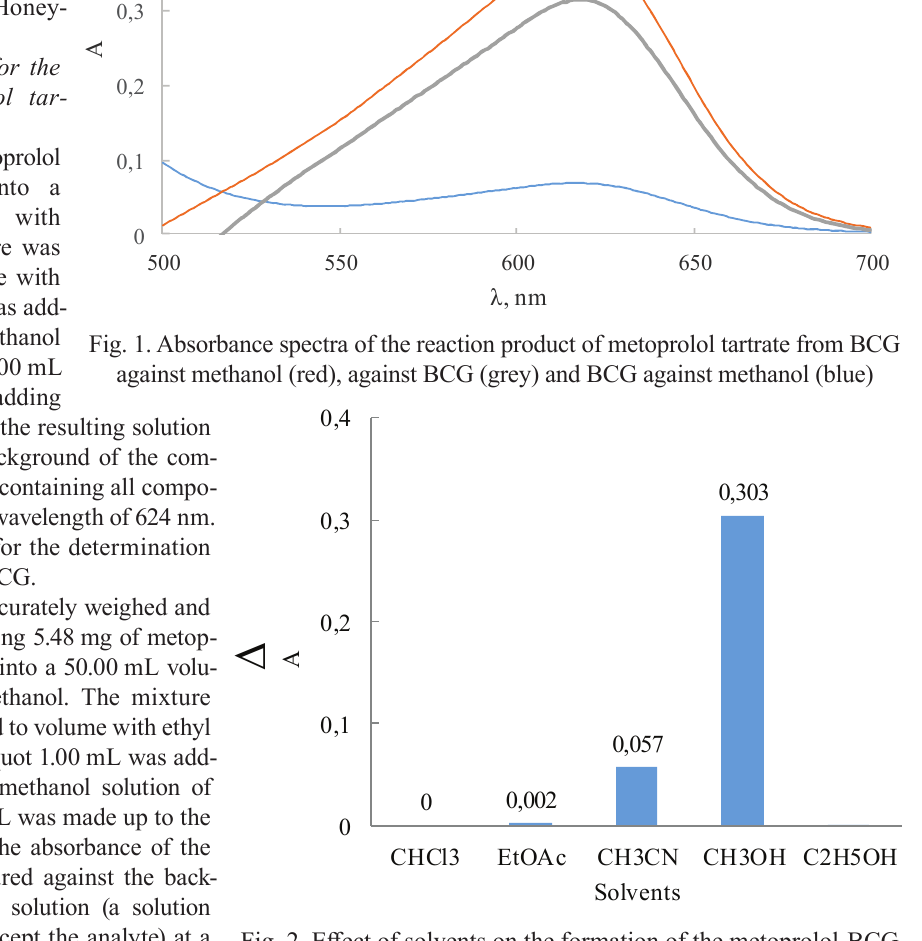
Fig. 2. Effect of solvents on the formation of the